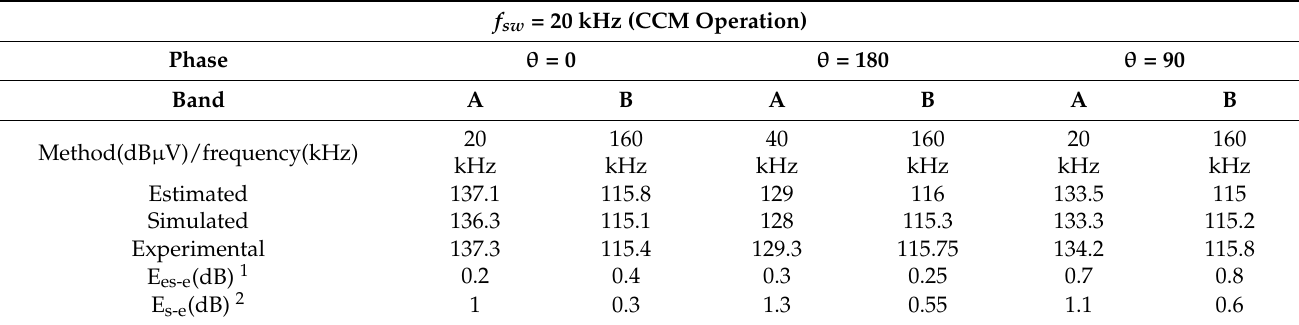
Table 6. Comparative DM Noise Results for the Case